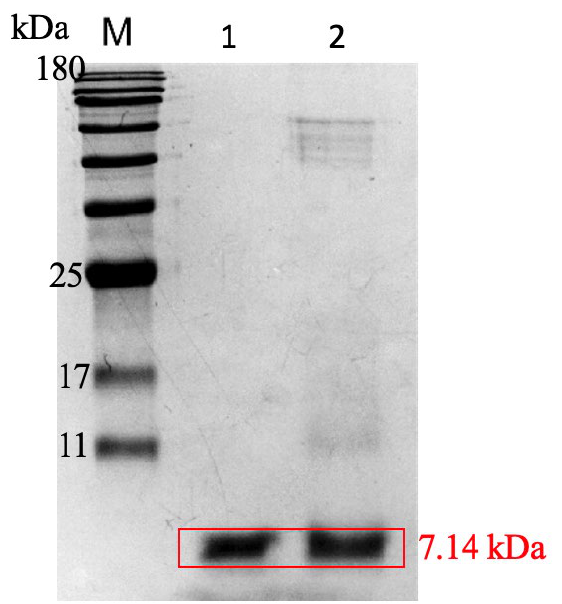
Figure 2. SDS-PAGE gel of the nano-formulation. Other than the marker (M), purified AS-48 (Lane 1) and PLGA[AS-48-BMNPs] (Lane 2) were loaded in the second and third lanes, respectively. Table 2. NTA data compared to the AFM diameter. NTA average size represents the average obtained from three independent measures while the NTA mode size is the value most frequently detected. The values correspond to three independent experiments for which standard deviations were